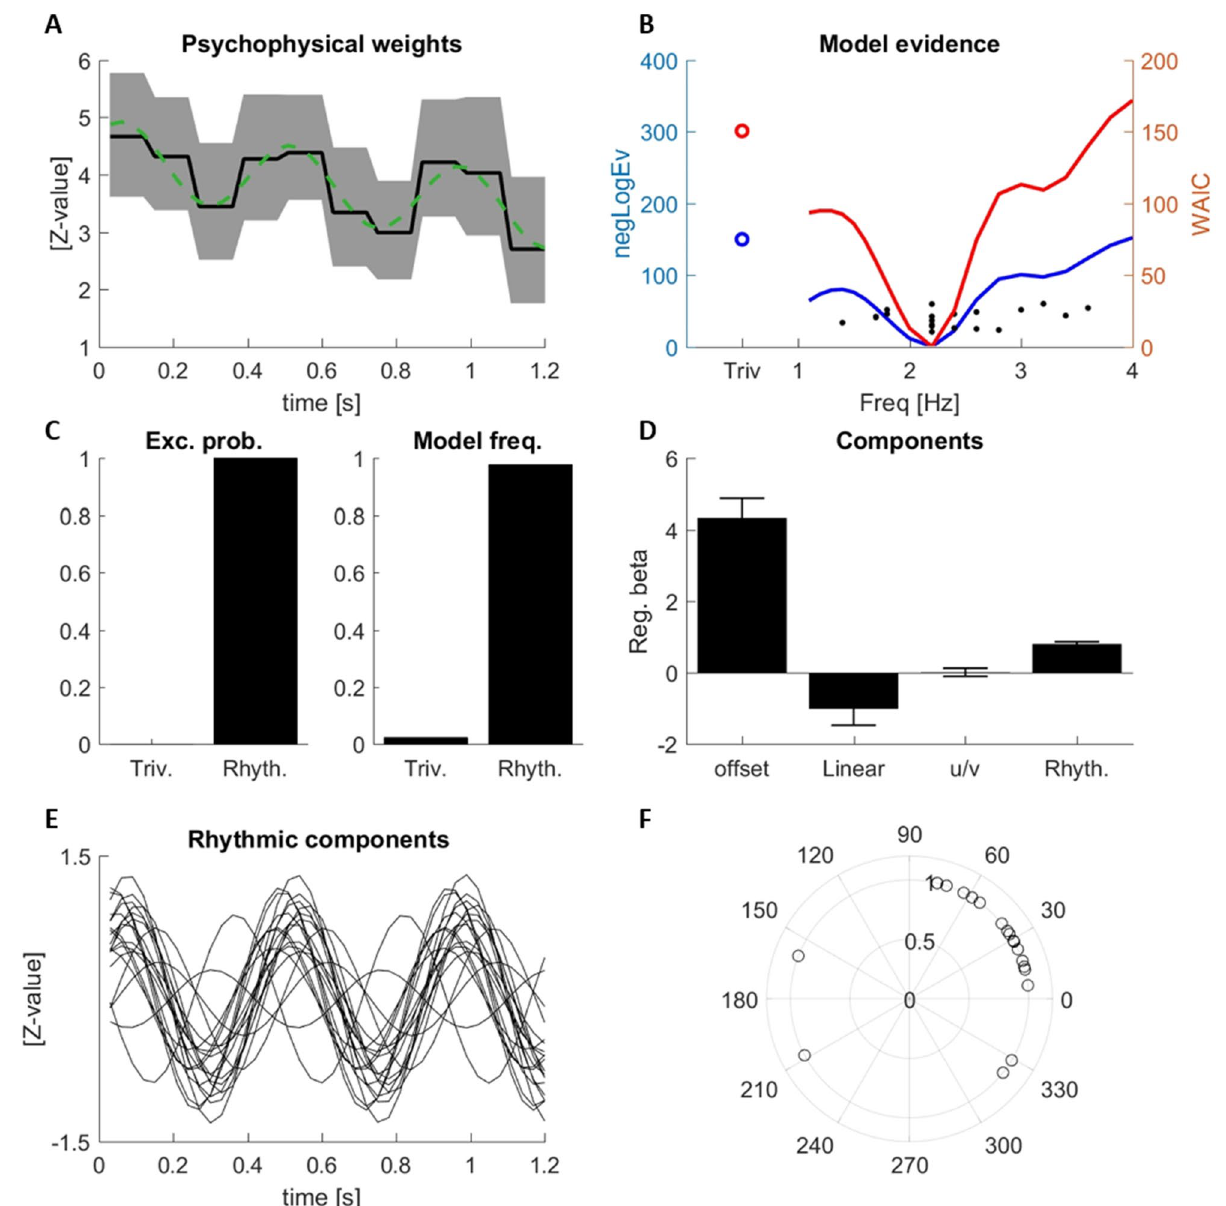
Figure 2. Perceptual weights. ( A ) Group-averaged perceptual weights (black line), two-sided 95% bootstrap confidence interval (grey area) and the best fitting models (group-average; green). ( B ) Model comparison between the trivial model (circle) and rhythmic models at different frequencies (lines) based on the group-level negative log-evidence (blue) and the WAIC (red). Dots indicate participant’s individual best frequencies (from negLogEv). ( C ) Exceedance probabilities and model frequencies comparing the trivial and a rhythmic model at the best rhythmic group-level frequency (2.2 Hz). ( D ) Regression betas for each model component (mean, s.e.m.): the overall offset, the linear slope, a u- or v-shaped contribution over the full duration and the rhythmic component; See Methods for details. For the rhythmic component the root-mean-squared amplitude of the combined sine and cosine components at 2.2 Hz is shown. ( E ) Rhythmic components of the best model for each individual participant. ( F ) Phase of the rhythmic component for each